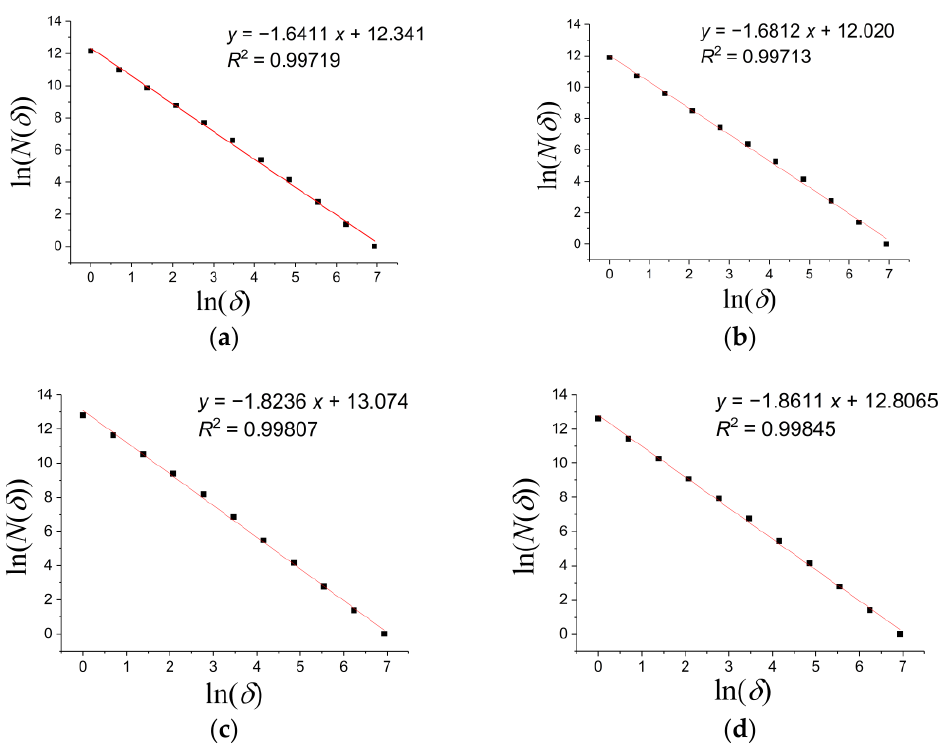
Figure 6. The calculation of the fractal dimension for the gypsum rock with different soak times: ( a ) Natural, ( b ) 7 days, ( c ) 15 days, and ( d ) 30 days. Table 2. The fractal dimension of the gypsum rock with different immersion times.